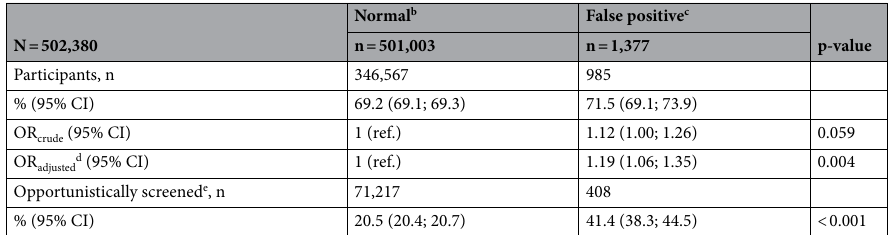
Table 2. Odds ratios of participation a in subsequent screening after receiving a false positive cervical cytology screening (index test) result compared to a normal result. a Participation 24–42 months after the date of the index test or surveillance test: b Adequate index test showing no dysplasia. c Abnormal index test showing high-grade cytological abnormalities with a subsequent cervical biopsy with normal or ‘Cervical intraepithelial neoplasia grade 1’ result within 6 months. d Adjusted for age, history of abnormal cervical test, and participation in screening within 42 months prior to the index test. e Women who had a subsequent cervical cytology cancer screening 24 to < 36 months after the index test or cervical surveillance